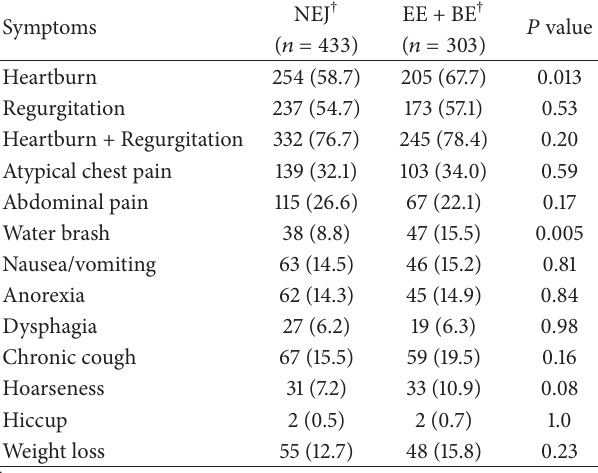
Table 3: Comparison of reflux symptoms in study